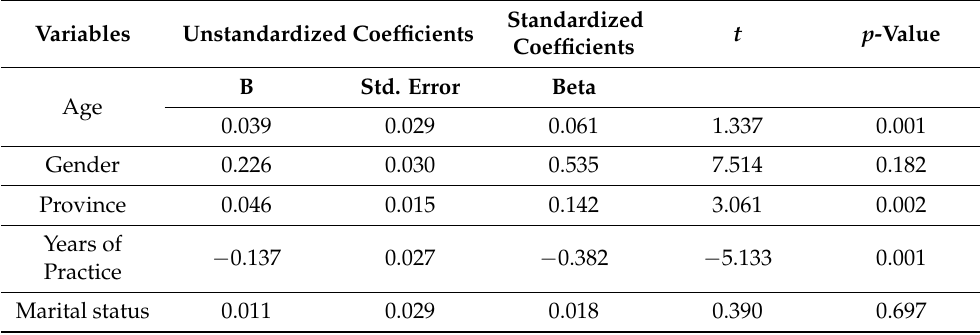
Table 2. Association of age, gender, province of residence, years of practice, and marital status with responses of the